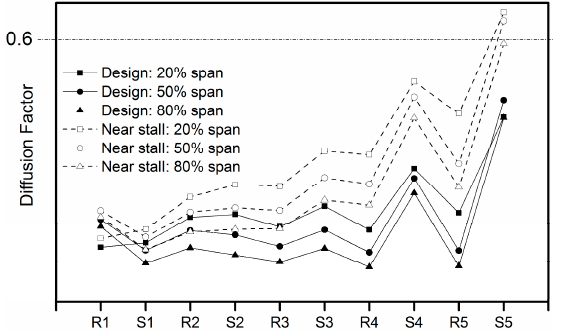
Figure 7. Limiting streamlines on the suction side of each blade at the near stall point.